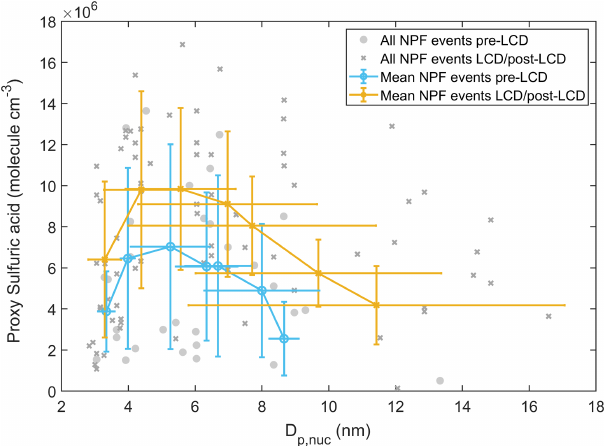
Figure 7. Scatter plot between geometric mean diameter of nucle- ation mode ( D p , nuc ) and the proxy sulfuric acid. The grey dots and crosses represent the NPF events during pre-LCD and LCD / post- LCD, respectively. The purple and blue lines represent the mean conditions during pre-LCD, LCD / post-LCD. The vertical and hor- izontal bars represents the standard deviations of sulfuric acid and D p , nuc .